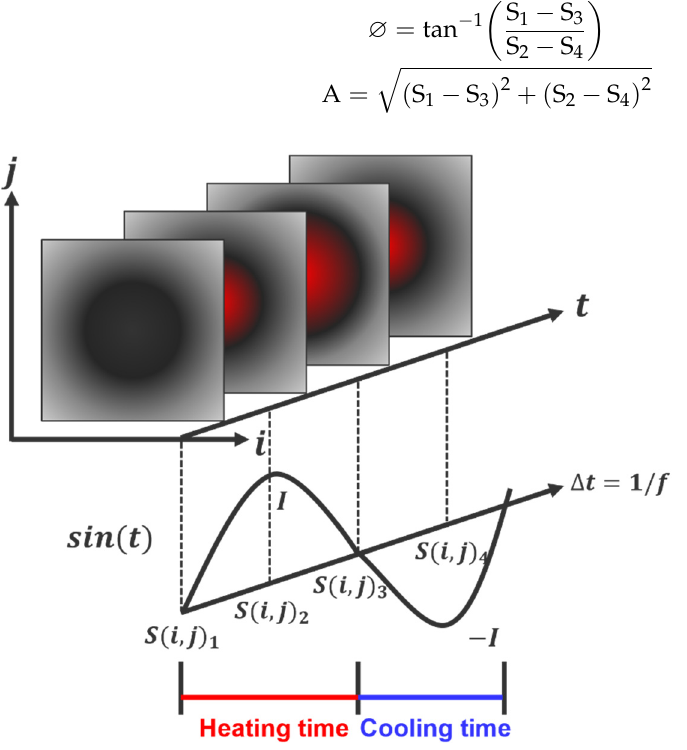
Figure 1. Principle of four-point signal processing to acquire phase and amplitude in LIT technique.